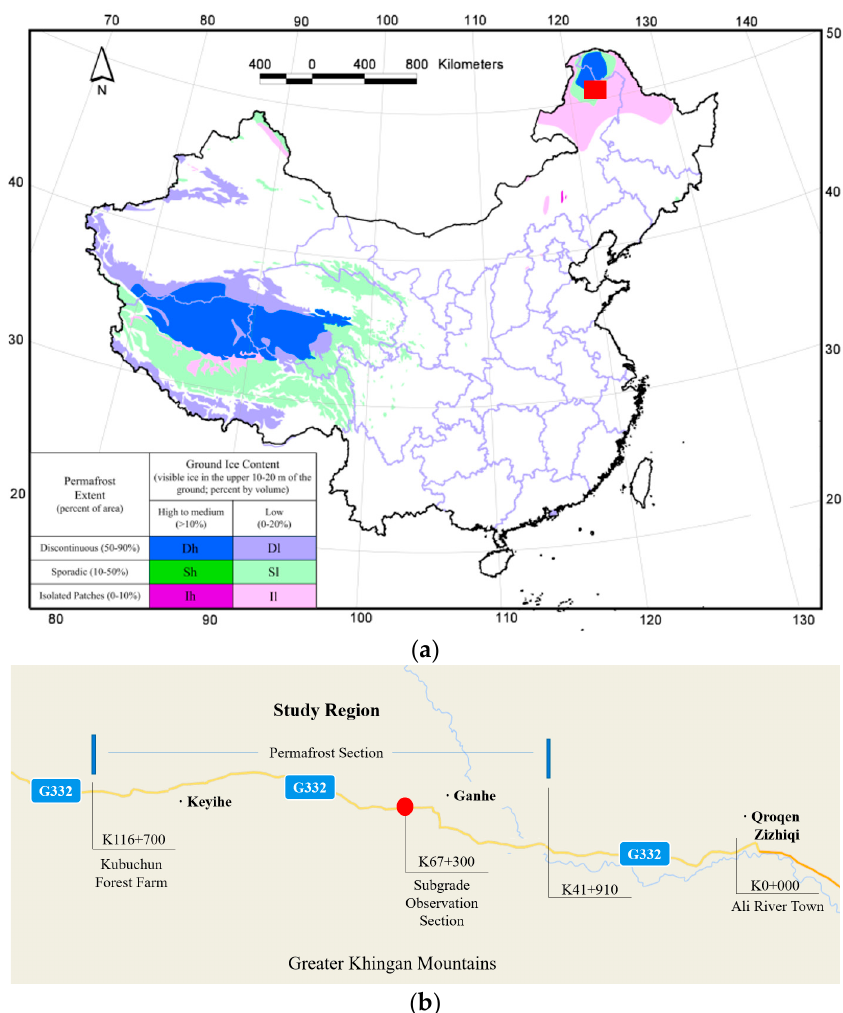
Figure 1. Map of the study region. ( a ) The location of the permafrost region of the Greater Khingan Mountains (red square) in China; ( b ) the location of the research project in the permafrost region of the Greater Khingan Mountains.